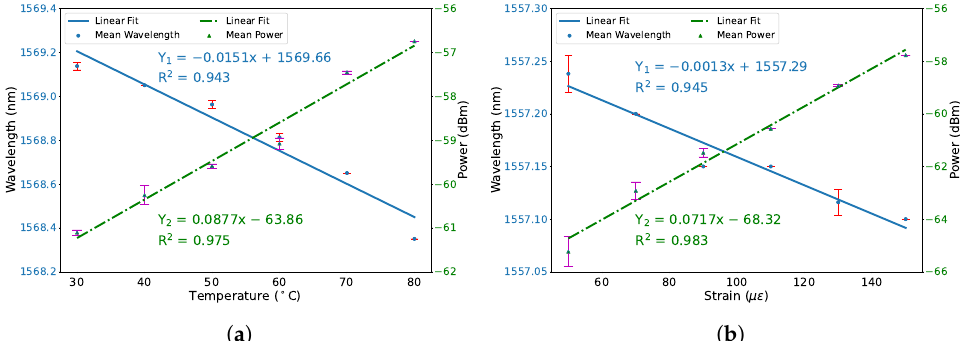
Figure 5. ( a ) Relation between average wavelength shifts and temperature, and the relation between average power changes and temperature. Error bar indicates the standard deviation. ( b ) Relation between average wavelength shifts and strain, and the relation between average power changes and strain. Error bar indicates the standard